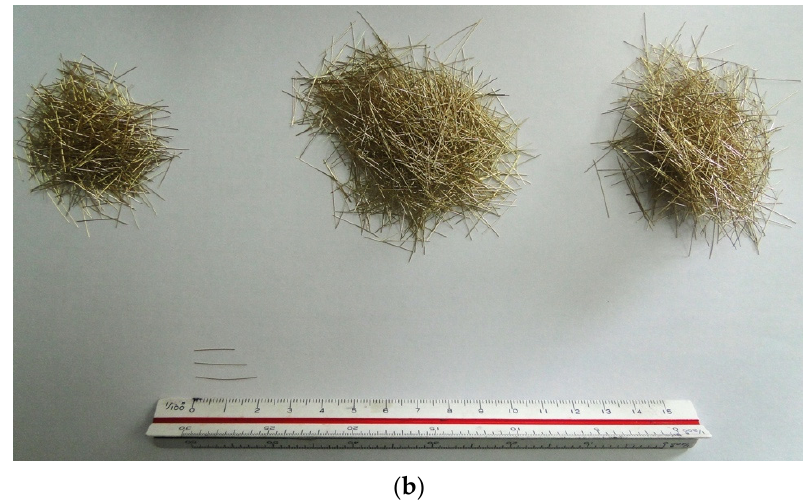
Figure 1. Details of test specimen (Unit: mm) and material: ( a ) Details of test specimens; ( b ) Fiber used for construction of test specimens. Table 1. Details of test specimens.